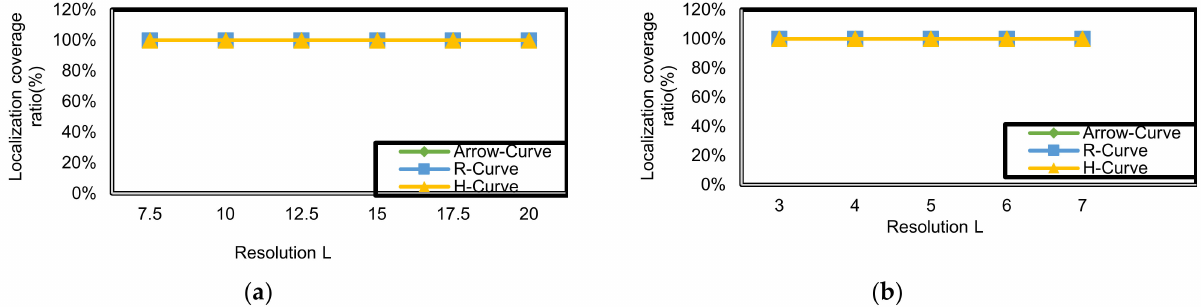
Figure 22. Localization coverage ratio corresponding to resolution (L) in Arrow-Curve path model, R-Curve path model, and H-Curve: ( a ) outdoor environment; ( b ) indoor environment.